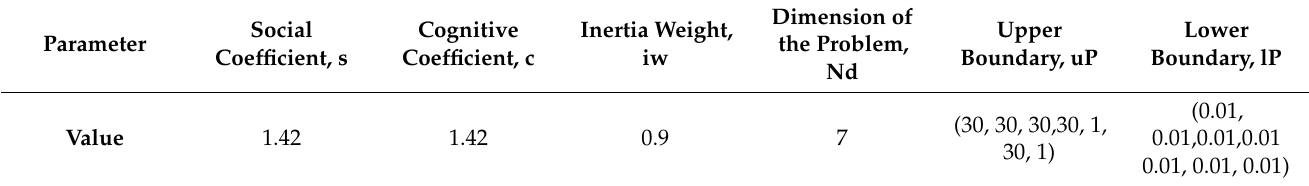
Table 3. The parameters of the proposed PSO algorithm.